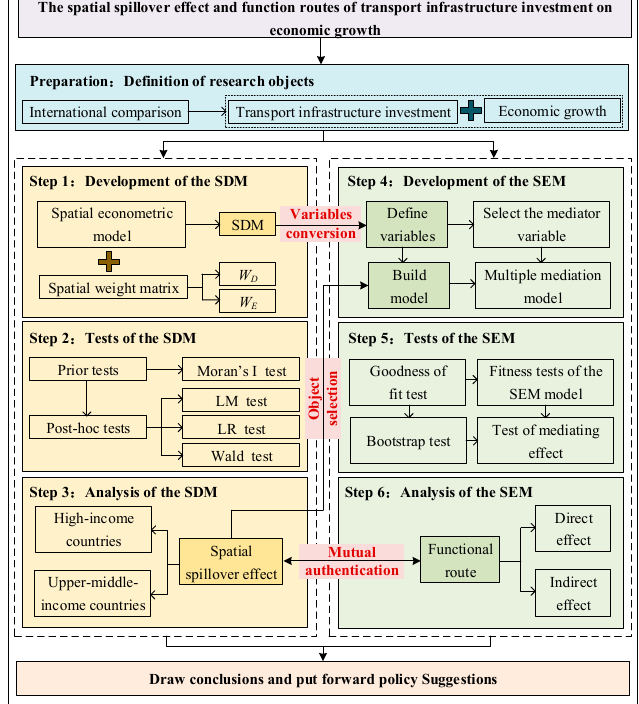
Figure 1. Work procedures.